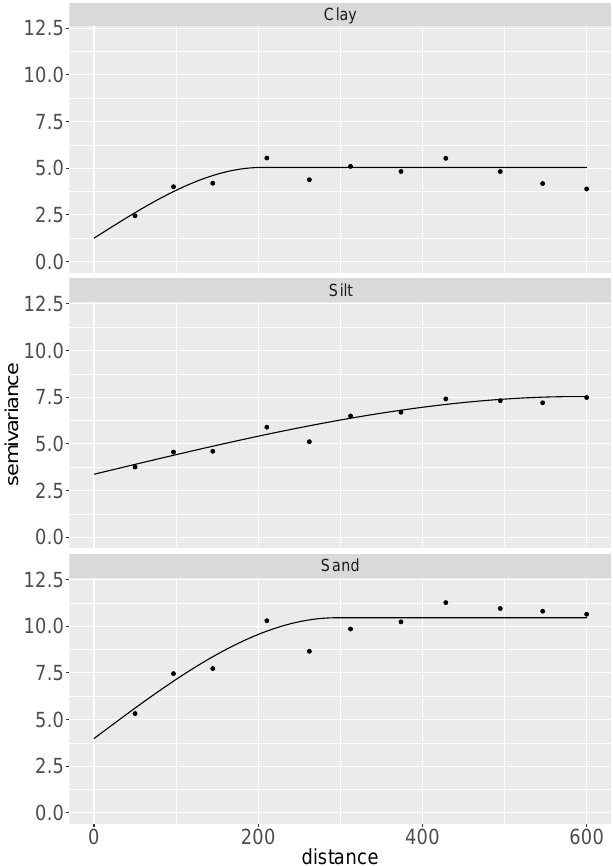
Figure 7. Experimental (dots) and fitted theoretical (line) variogram of the residual term of Equation (7) for texture classes clay ( top ), silt ( middle ) and sand ( bottom ). Distance units are in [m].